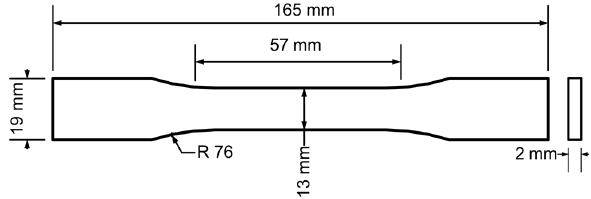
Figure 2 Schematic of dog-bone-type specimen for tensile test.